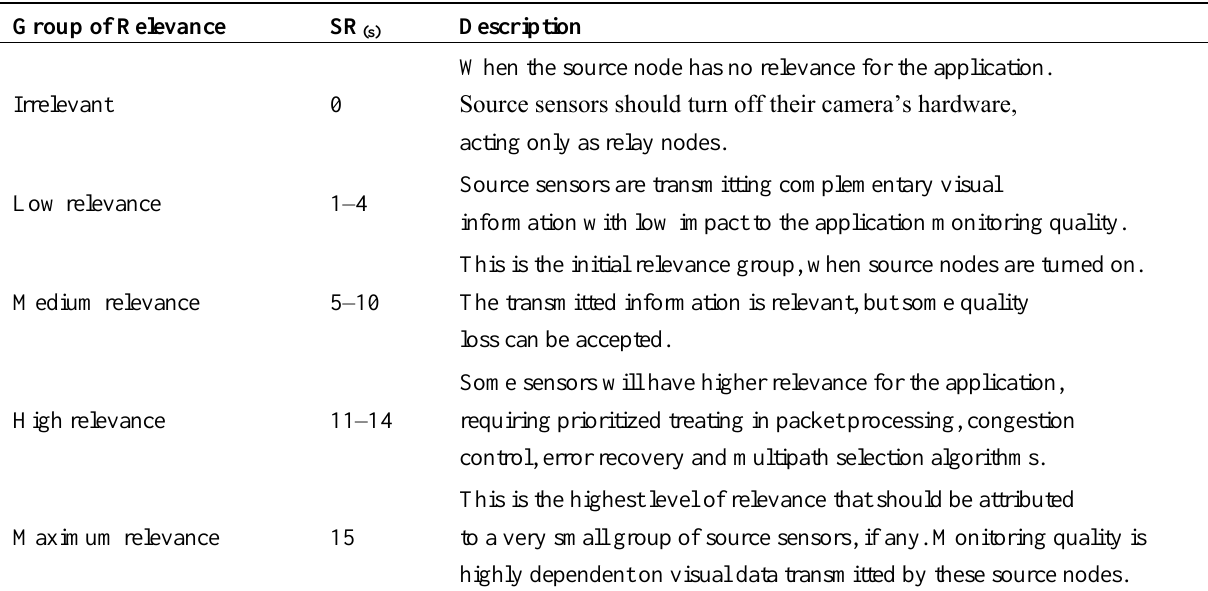
Table 1. Groups of relevance and the associated Sensing Relevance index (SR). Group of Relevance